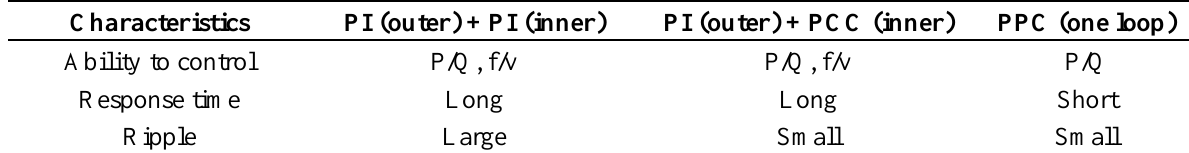
Table 4. Characteristics of MPC and PI control